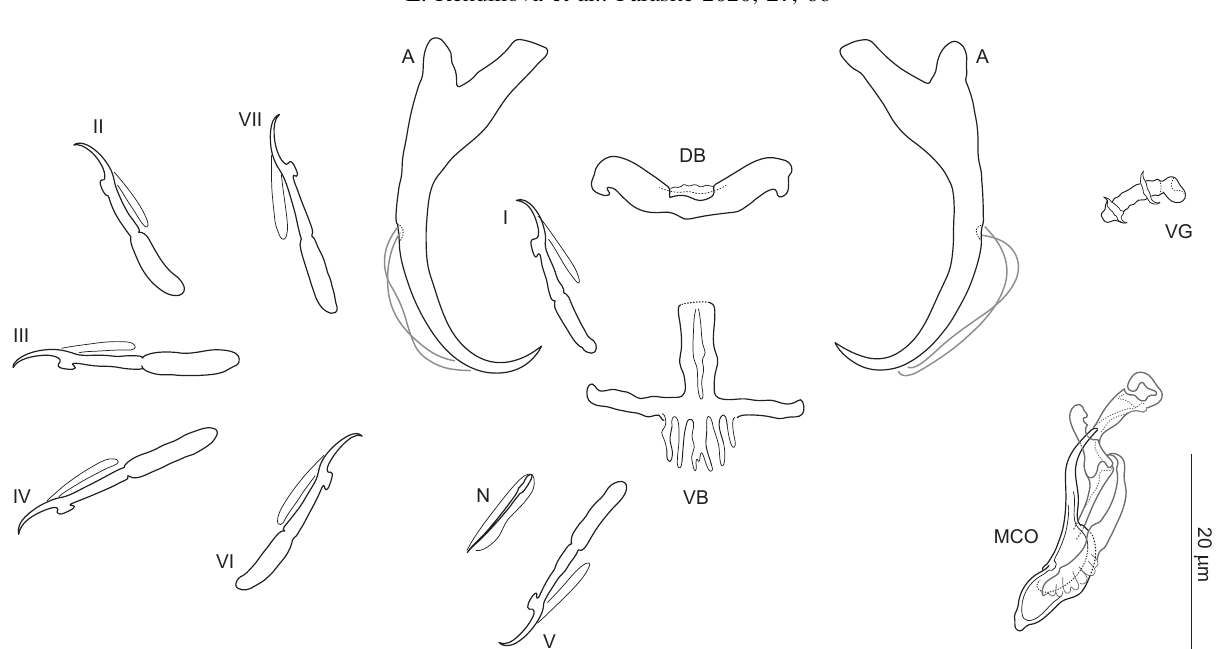
Figure 9. Sclerotized structures of Dactylogyrus sandai n. sp. ex Telestes karsticus . A, anchor; DB, dorsal bar; VB, ventral bar; N, needle; I – VII, hooks; VG, vagina; MCO, male copulatory